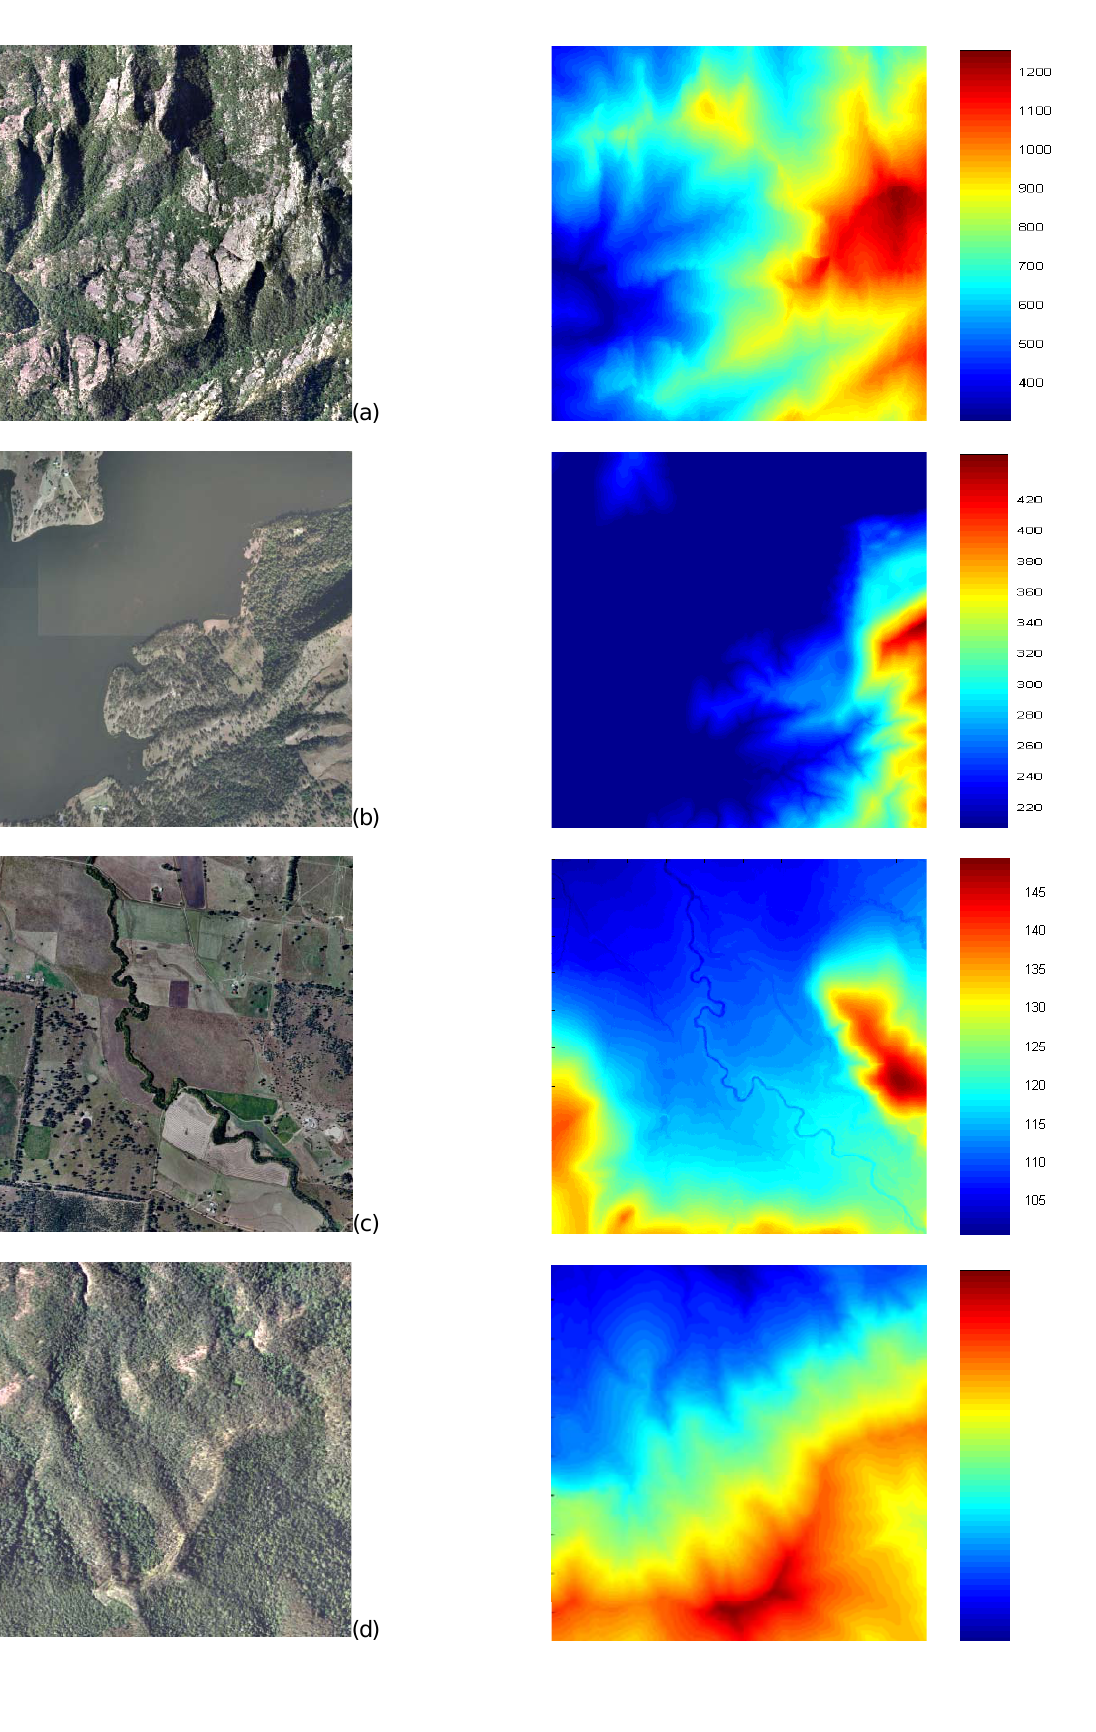
e elevation images are ley and (d)